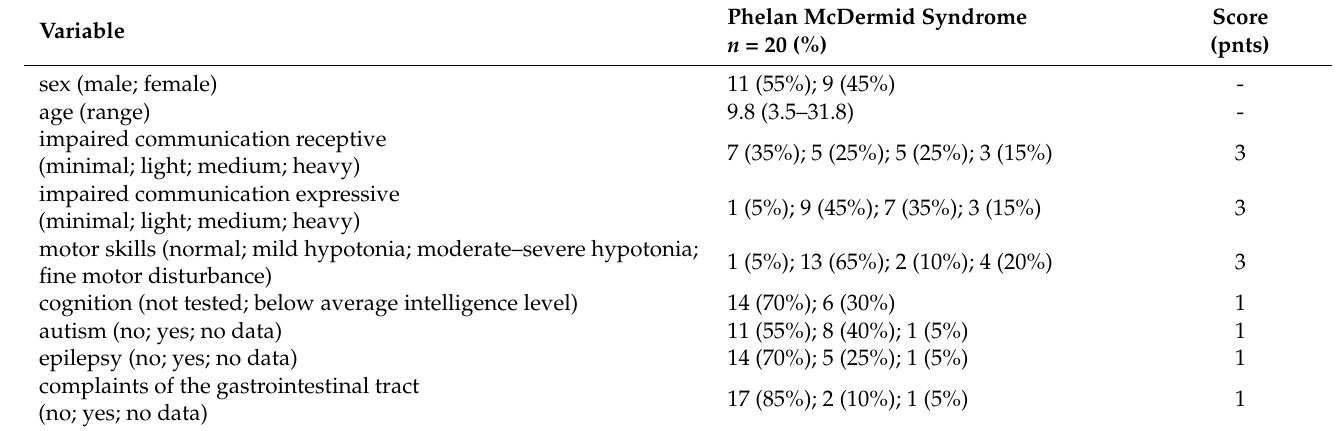
Table 1. Clinical characteristics and symptoms of 20 patients with Phelan-McDermid syndrome. A disease burden score was built from these symptoms to assess disease burden. The possible scores for the various clinical symptoms are given, with a high number of points representing the most severe disease burden in each case. An additional point could be given for further